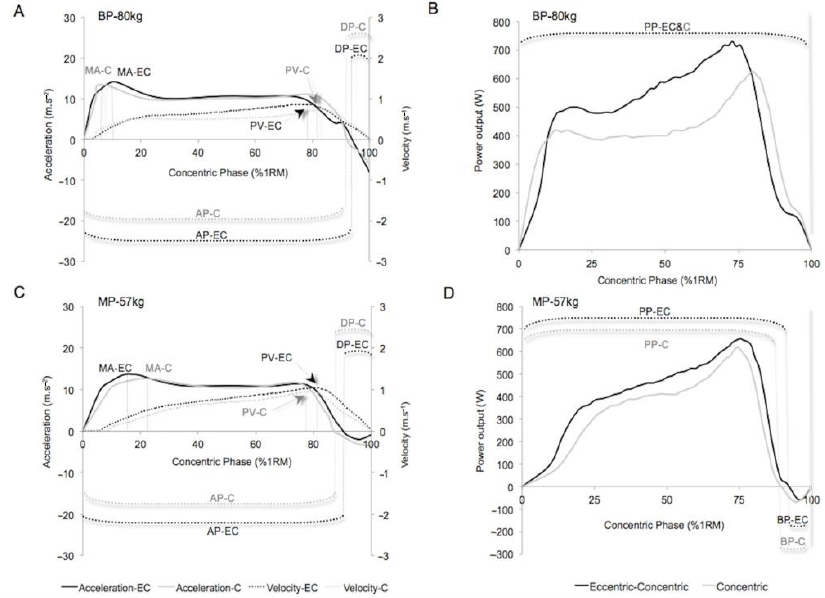
Figure 5. Example of differences between eccentric – concentric (EC) vs. concentric ( C ) phases when lifting the same heavy load for a representative subject. ( A ) Acceleration and velocity curves in bench press. ( B ) Power output curves in bench press. ( C ) Acceleration and velocity curves in military press. ( D ) Power output curves in military press. Abbreviations used in A,C: AP = acceleration phase; DP = deceleration phase; MA = peak acceleration; PV = peak velocity. Abbreviations used in B,D: BP = braking phase; PP = propulsive phase.